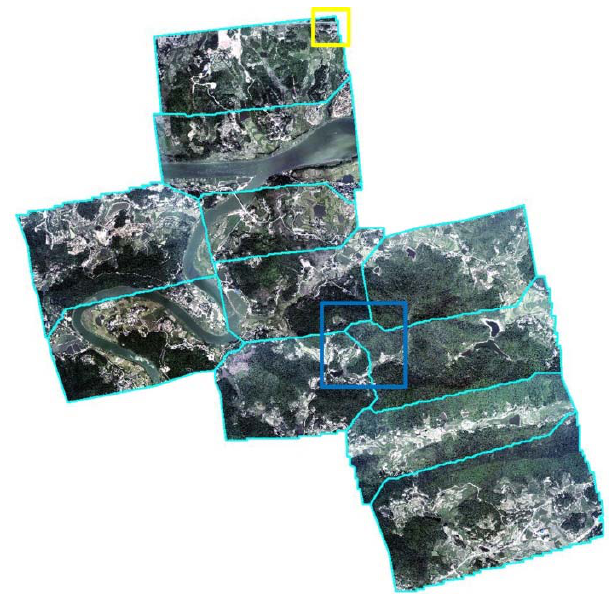
Figure 6. The generated seamline network overlapping the mosaic of Data Set 1 by the presented method.